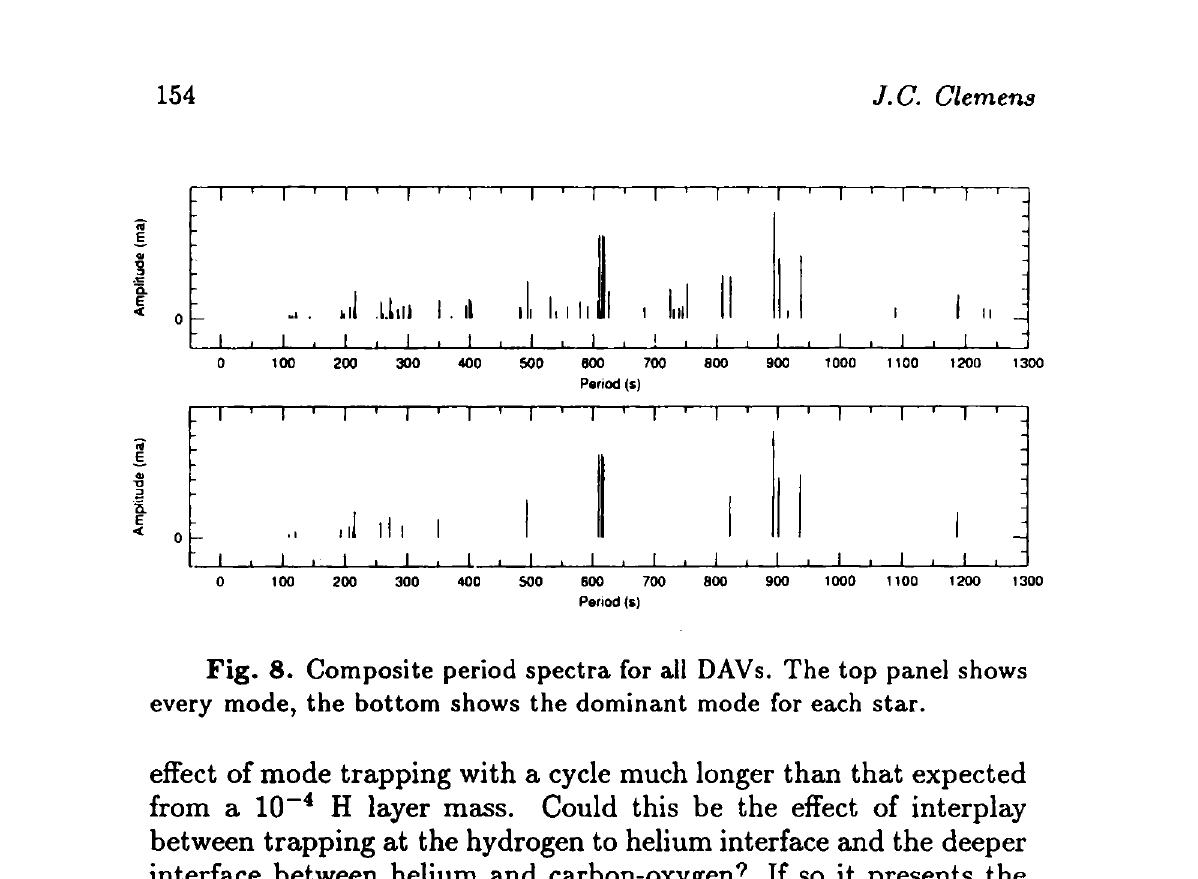
F i g. 8. Composite period spectra for all DAVs. The top panel shows every mode, the bottom shows the dominant mode for each